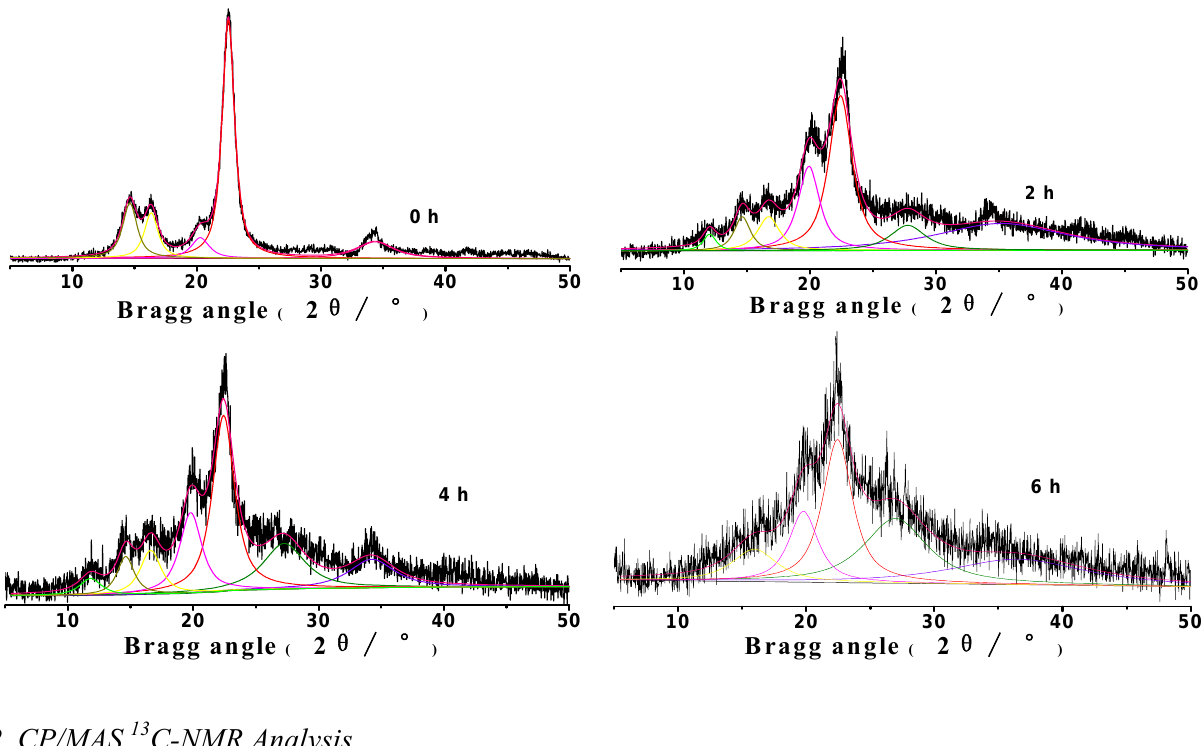
Figure 2. X-ray diffraction patterns of MCC samples with phosphoric acid at 50 °C. The characteristic peaks of cellulose I were: 2 θ = 14.7°, 16.5°, 22.8°, and 34.5°; The characteristic peaks of cellulose II were: 2 θ =12° and 20°.